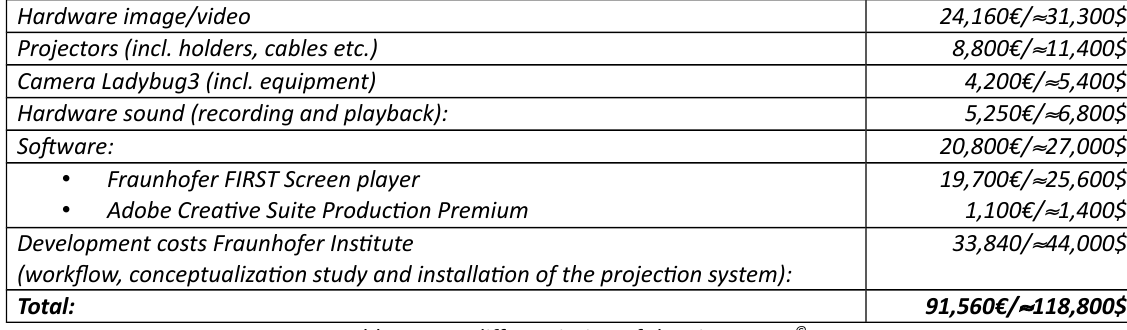
Table 1. Cost diferentaton of the SimuScape